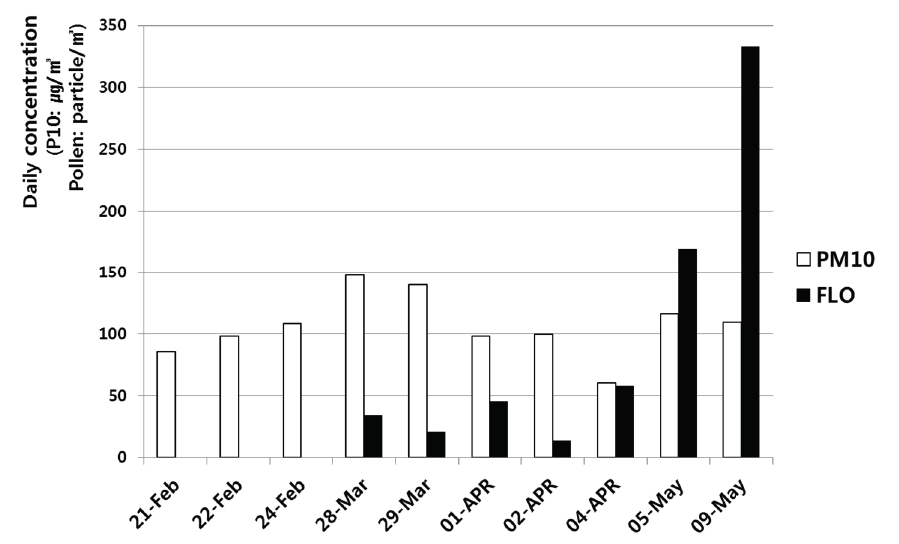
Figure 3. PM 10 and pollen dispersions. The three event days when the PM 10 was >100 µg/m 3 were 24 February, 29 March, and 5 May. PM 10 , PM 10 concentration; FLO, pollen concentration.